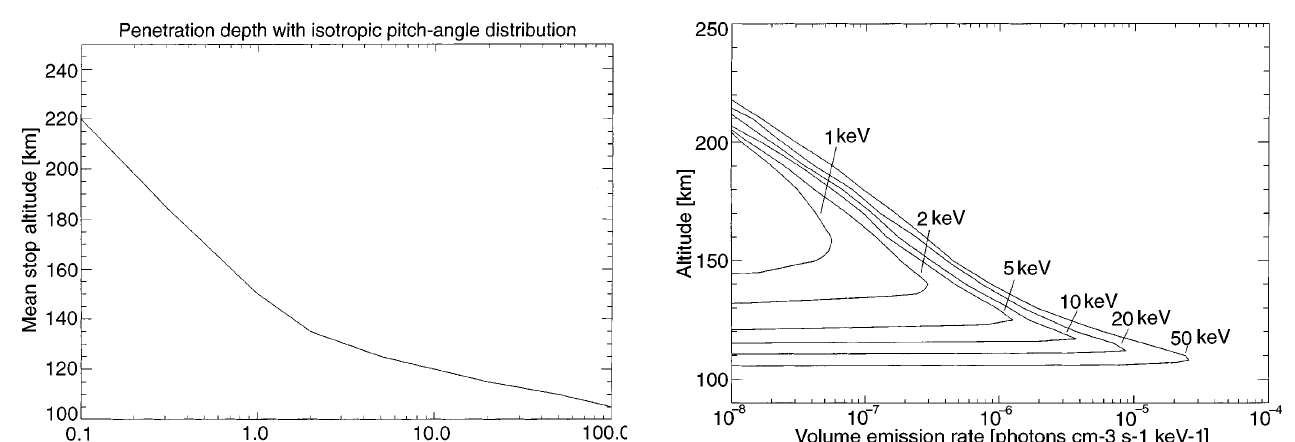
Fig. 5. Modeled auroral hydrogen arc in the east-west geomagnetic direction, for particles with injection energies of 5 keV and isotropic pitch angle distribution